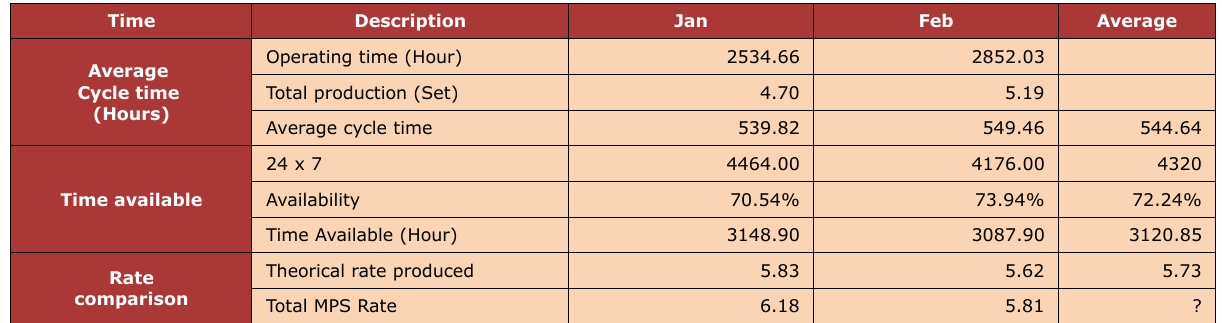
Table 3. Historical data as reference of future